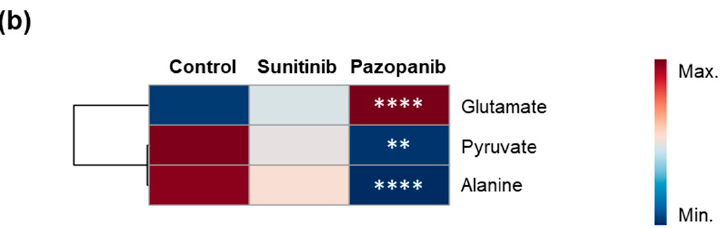
Figure 5. Impact of pazopanib on the exometabolome (extracellular metabolites present in culture medium) profile of HK-2 cells. ( a ) PLS-DA scores scatter plot (left) and loading plot (right) obtained for non-exposed cells (green circles, n = 5) vs. cells exposed to 50 µ M pazopanib (blue circles n = 5). ( b ) Heatmap illustrating the mean levels of metabolites changing in culture media of HK-2 cells after exposure with 50 µ M pazopanib. Rows correspond to the mean normalized peak area of each metabolite colored from minimum value (dark blue) to maximum value (dark red), while the columns represent each sample group. The control group represented in the first column corresponds to non-exposed cells. The statistical significance was assessed by comparison with the control cells (** p < 0.01, **** p < 0.0001). Abbreviations: Ala—alanine, Glu—glutamate, Phe—phenylalanine, Tyr—tyrosine. Table 2. List of metabolites significantly altered in the exometabolome (culture medium) of Caki-1 and HK-2 cells after exposure with 2 µ M sunitinib or 50 µ M pazopanib in comparison with the corresponding non-exposed cells